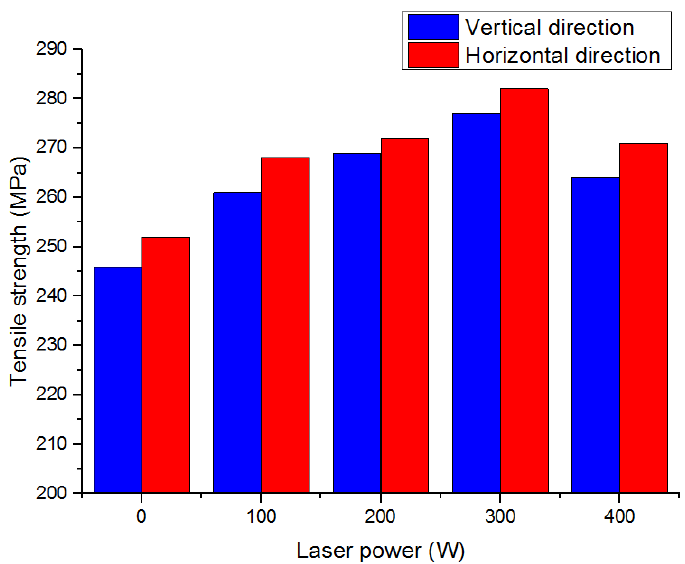
Figure 10. The influence of different laser powers on tensile strength.